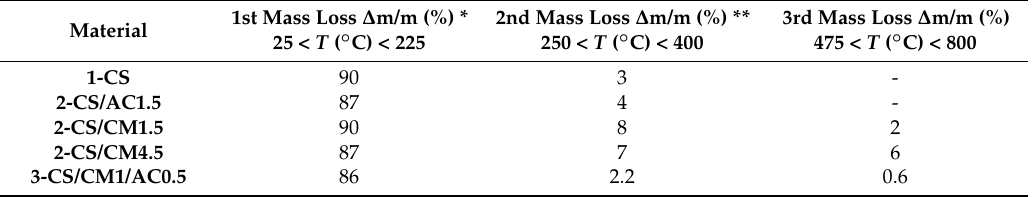
Table 2. Contents of water and chitosan (CS) determined by thermogravimetric analysis.